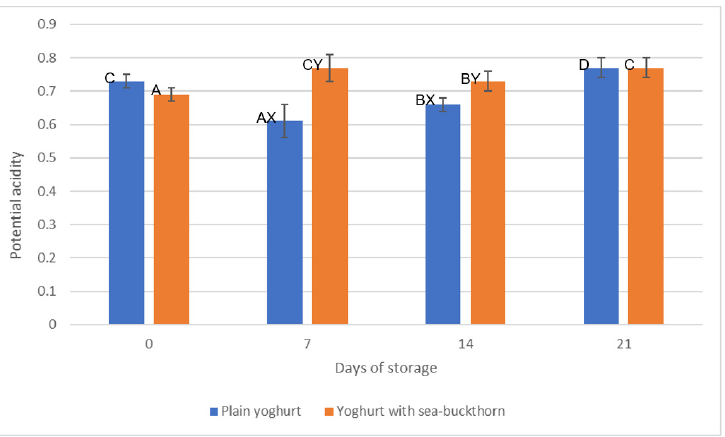
Figure 1. Changes of pH value in the analysed yoghurts during 21 days of storage in the refriger- ated conditions. A, B, C, D—differences between the pH value within a yoghurt type, significant at p ≤ 0.01. x, y, X, Y—differences between days of storage regardless of yoghurt type; x, y—signifi- cant differences at p ≤ 0.05; X, Y—significant differences at p ≤ 0.01.